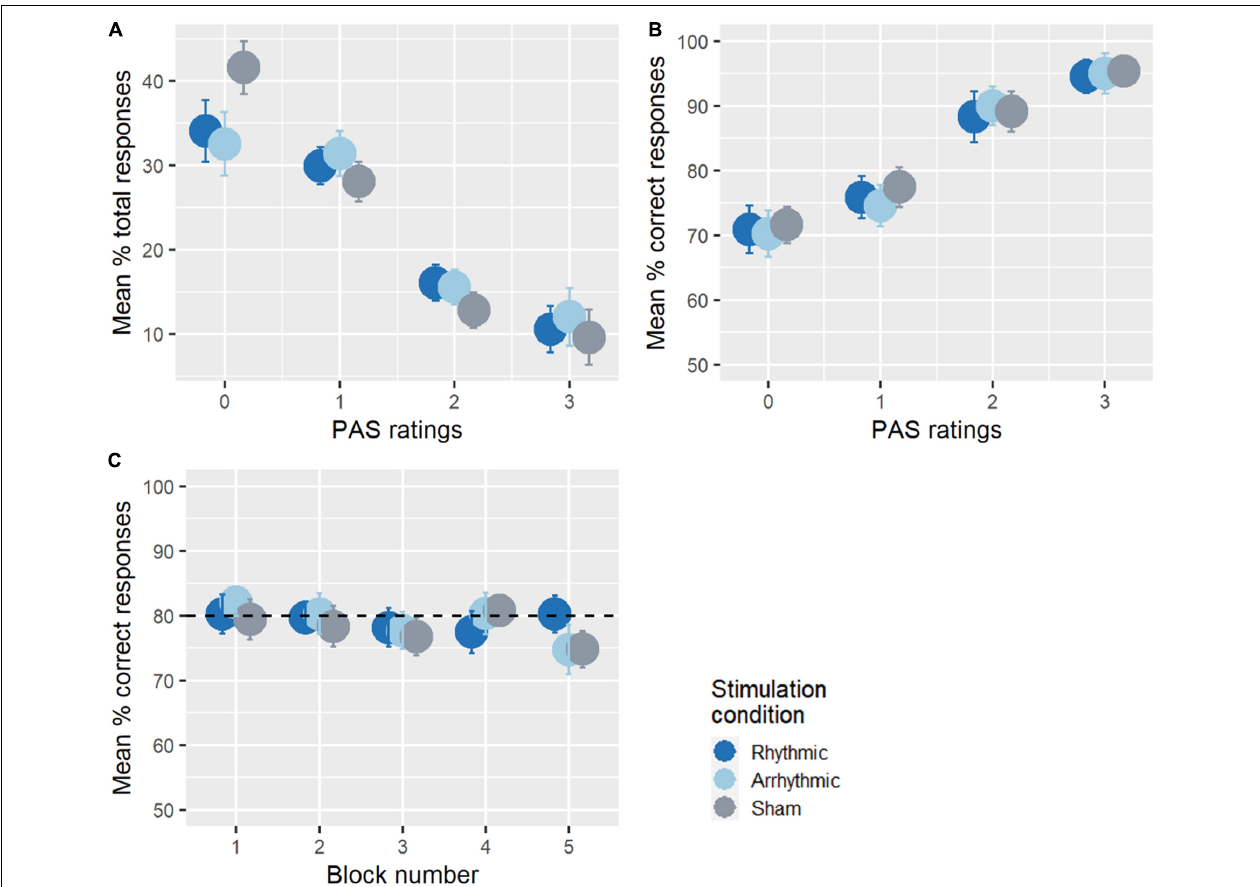
FIGURE 2 | Overall task performance. (A) The use of the PAS ratings across the experiment. On average, participants reported having more “no experience” (PAS = 0) or “brief glimpse” (PAS = 1) than “almost clear experience” (PAS = 2) or “clear experience” (PAS = 3) of the stimulus. (B) Average percentage of correct responses as a function of the PAS ratings. The accuracy of the participants increased with awareness. (C) Accuracy across experimental blocks. There was no significant difference between accuracy across the blocks during the 10 Hz-TMS sham condition. The performance of the participants was around 80% of their detection threshold throughout the entire experimental session, indicating that stimulus-titration was successful.